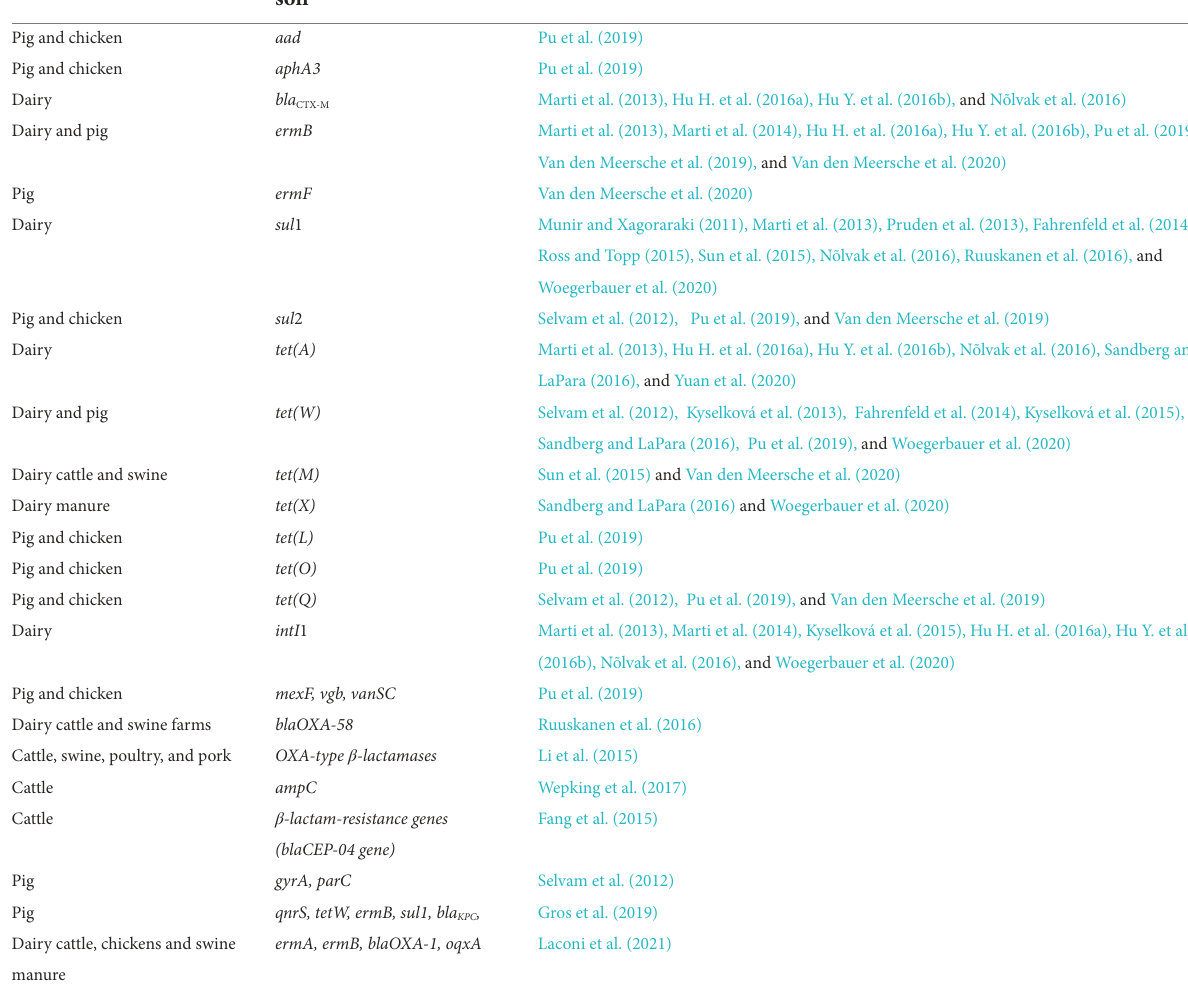
TABLE 3 The ARGs detected in animal manure. Animal